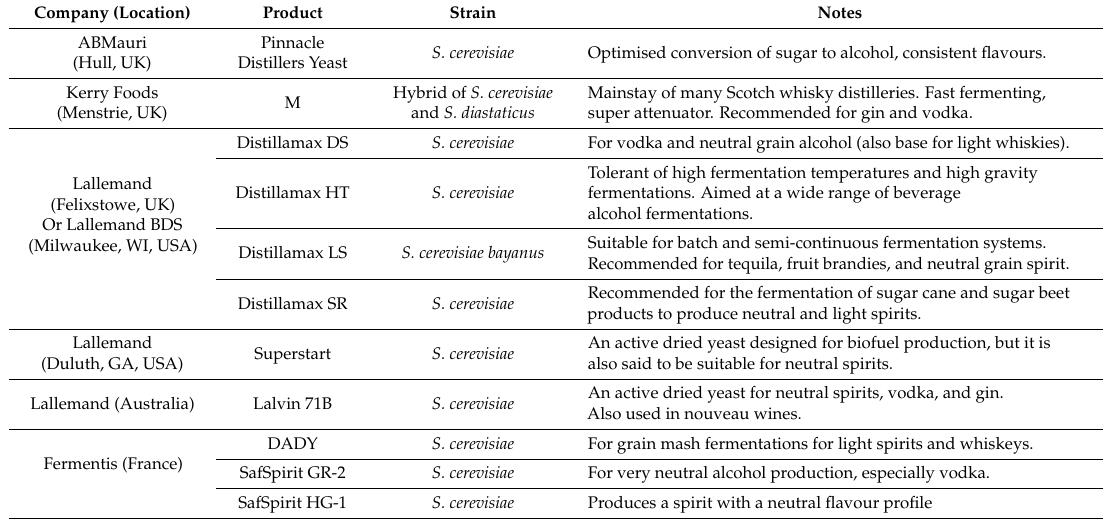
Table 2. Commonly available commercial yeast strains for the production of spirits to be further processed into gin or